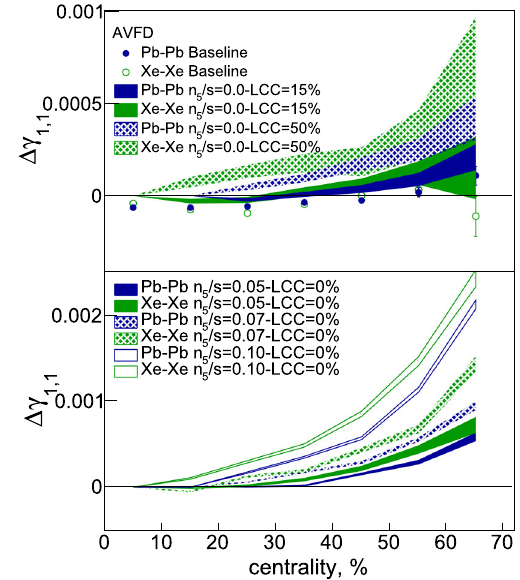
Fig. 6 The centrality dependence of (cid:9)γ 1 , 1 grouped in two scenarios: zero n 5 / s but various choices of LCC (upper panel) and non-zero n 5 / s but LCC fixed to zero (lower panel). The various bands show the AVFD expectations for (cid:9)δ 1 for Pb–Pb collisions and Xe–Xe collisions, with blue and green bands, respectively. The results of the baseline sample are represented by the filled and open